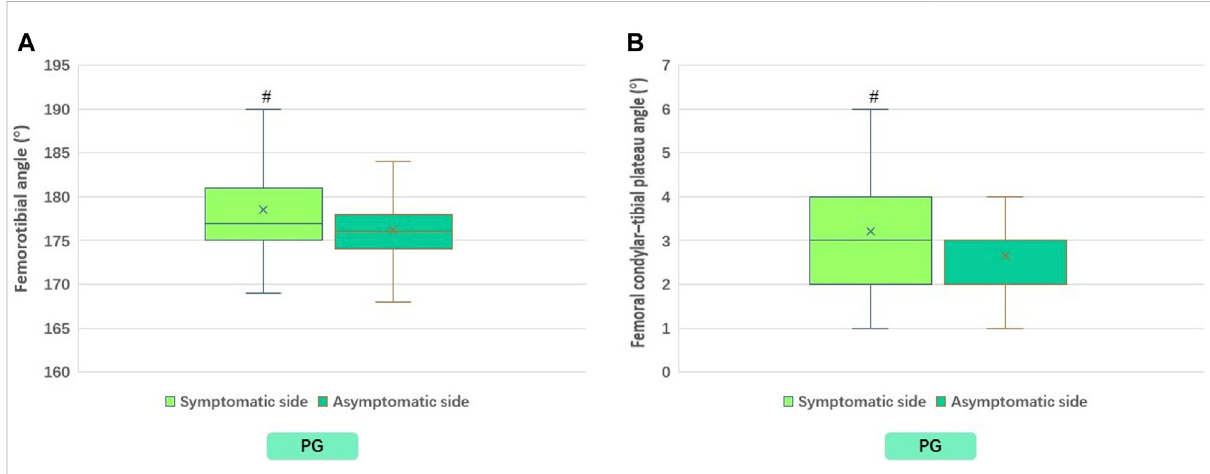
FIGURE 4 Differences between symptomatic and asymptomatic sides of PG in FTA (A) , and in FCTP (B) . PG, patient group. FTA, femorotibial angle; FCTP, femoral condylar – tibial plateau angle. # p < 0.01; Compared to